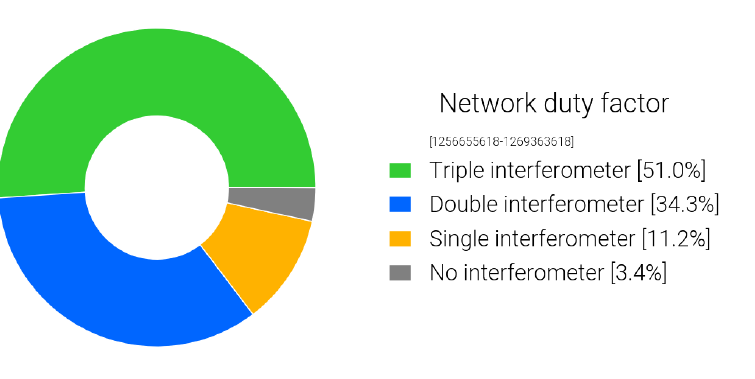
Figure 10. Top: Duty cycle of Advanced Virgo during O3b. Bottom: Duty cycle of the Gravitational Waves Network of the three Advanced detectors Virgo (V1), LIGO Livingston (L1) and LIGO Hanford (H1) during O3b. Bottom image from